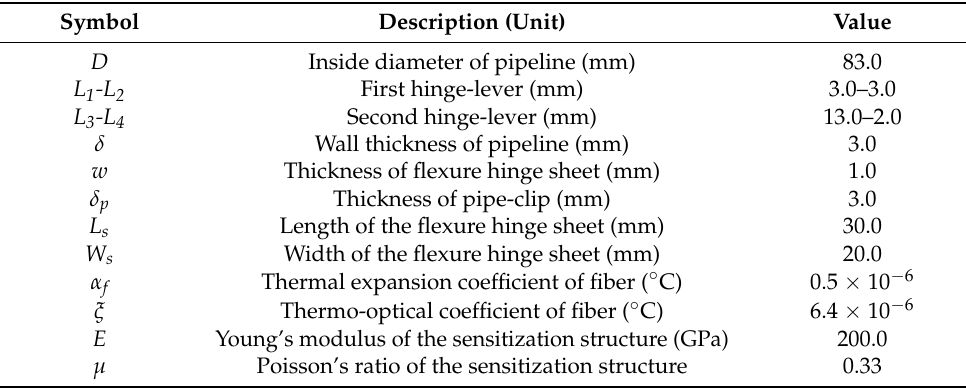
Table 2. Dimensions and material parameters of the sensitization structure.